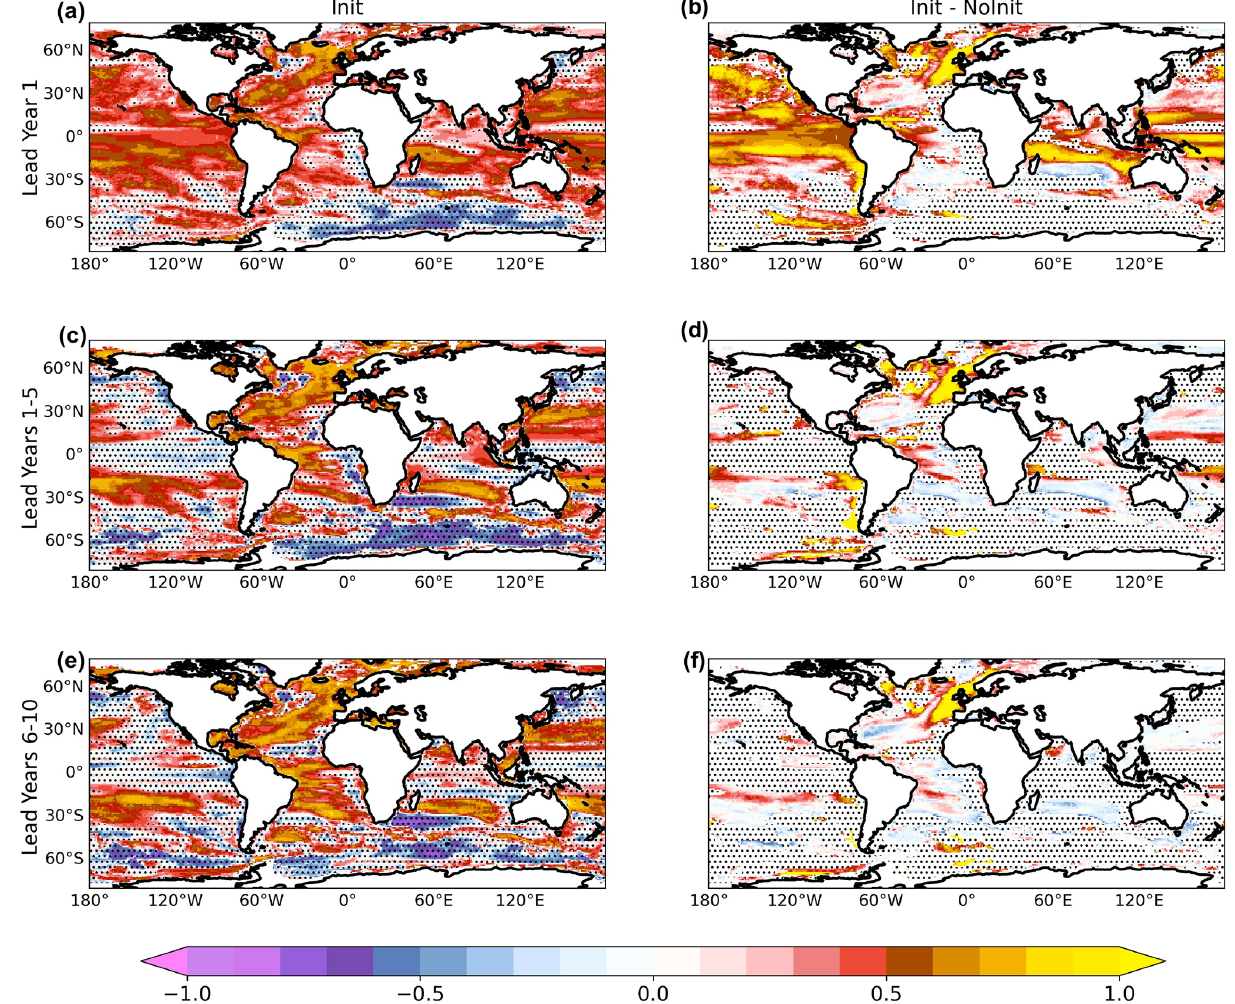
Figure 4. Same as Fig. 2 but for the ocean heat content integrated over the top 300m